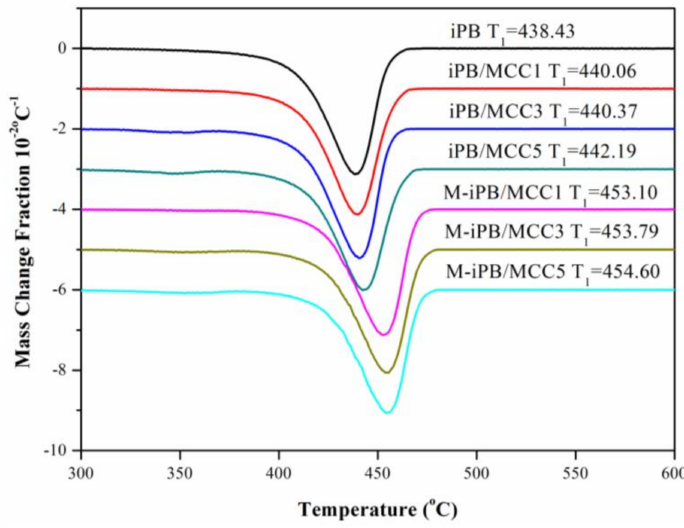
Figure 7. Derivative thermogravimetric analysis (DTG) curve of iPB/MCC